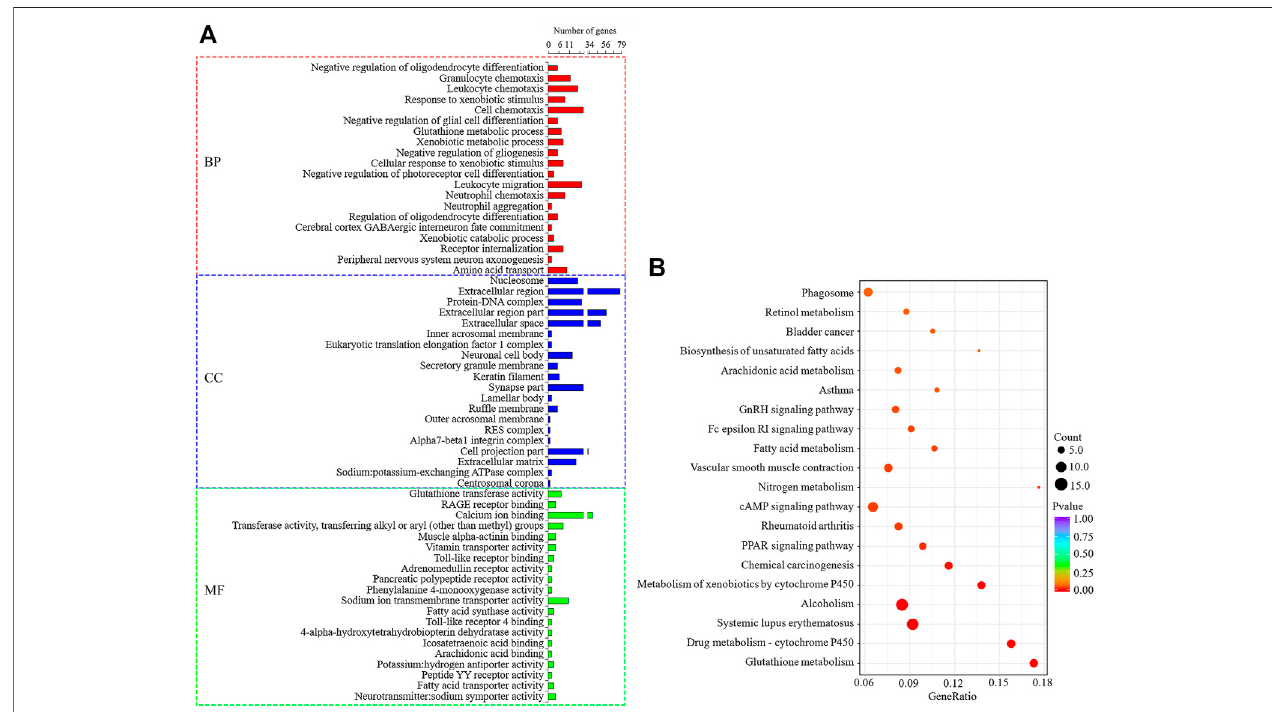
FIGURE 7 | GO and KEGG enrichment analysis of DELs target genes predicted by co-expression. (A) : The fi rst 20 signi fi cant GO items ( p < 0.05). (B) : The fi rst 20 KEGG enrichment results.